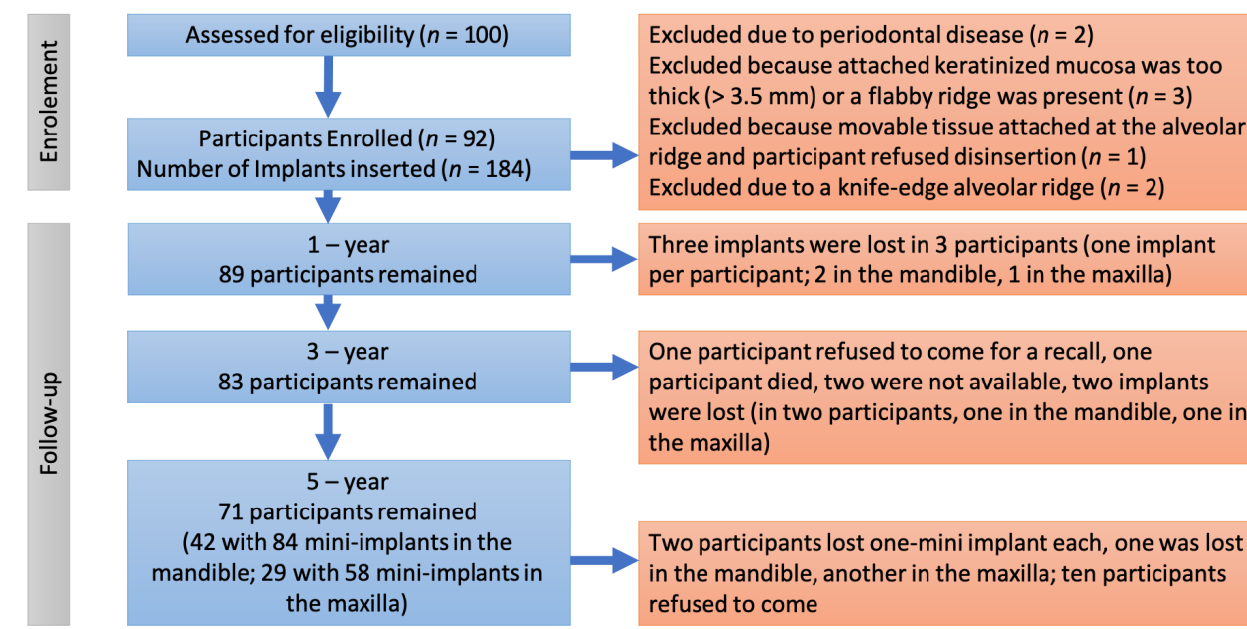
Figure 1. Flow chart of the study.